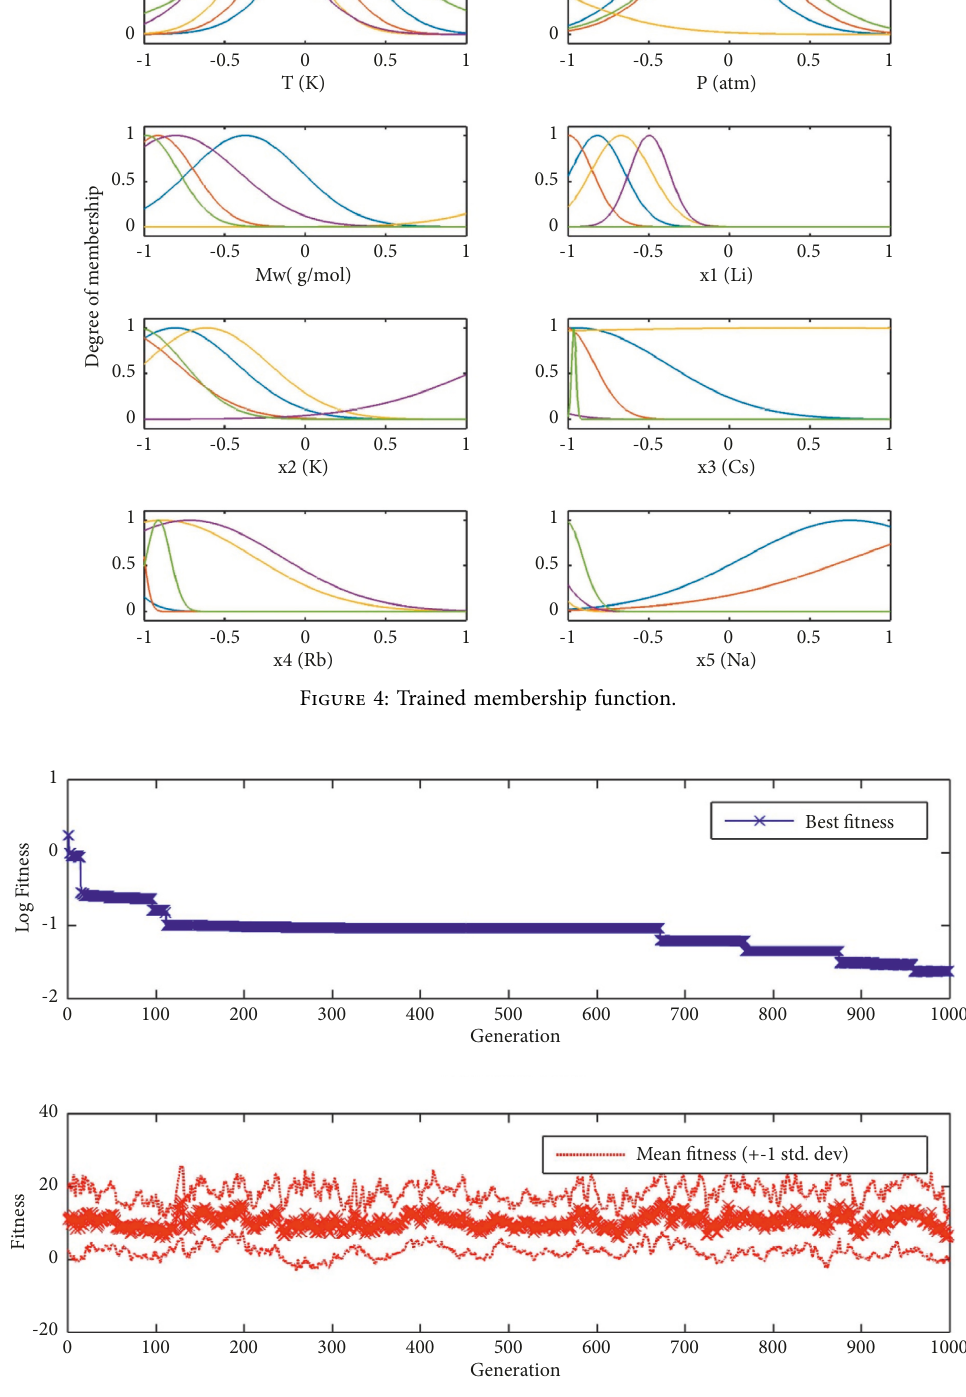
Figure 5: Determination of optimum fitness value through the change of